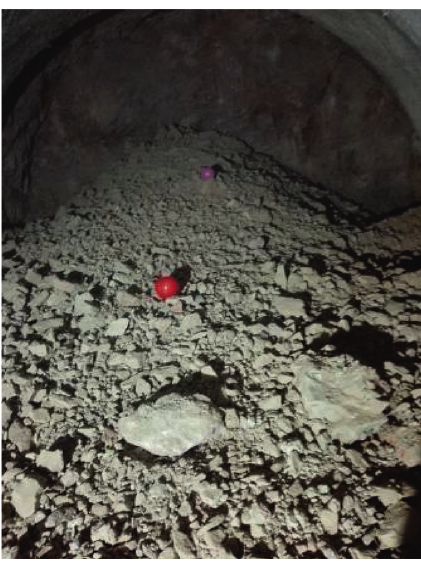
27: The picture of tunnel blasting effect.